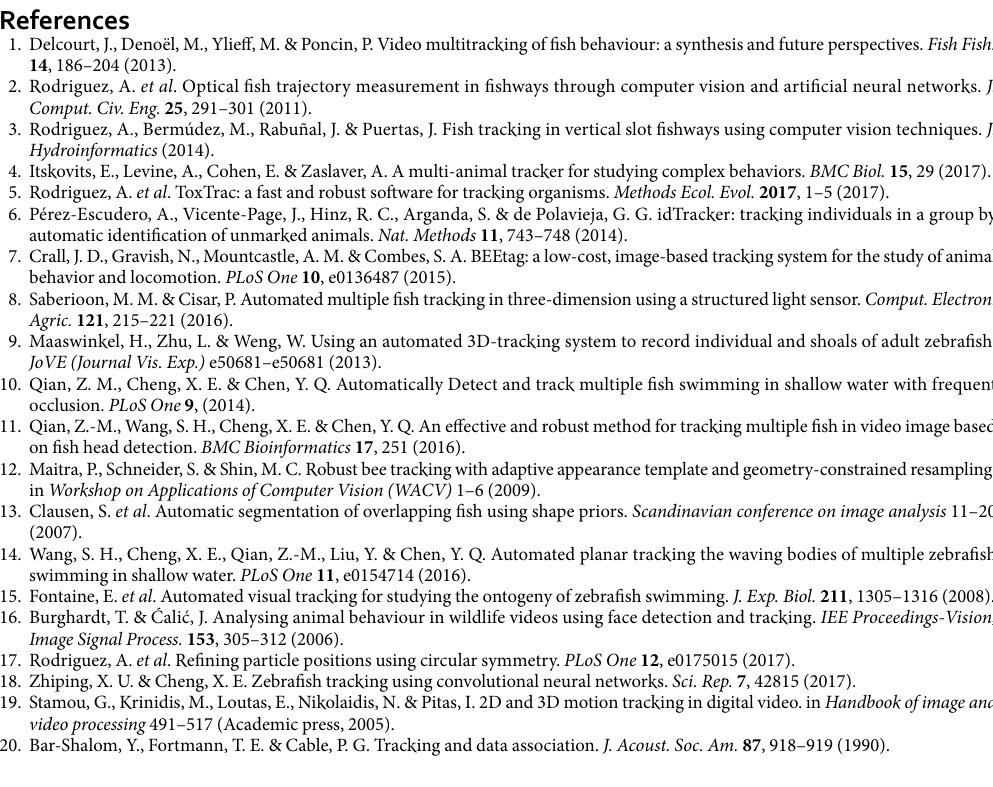
7 Scientific REPORts | 7: 14774 | DOI:10.1038/s41598-017-15104-2